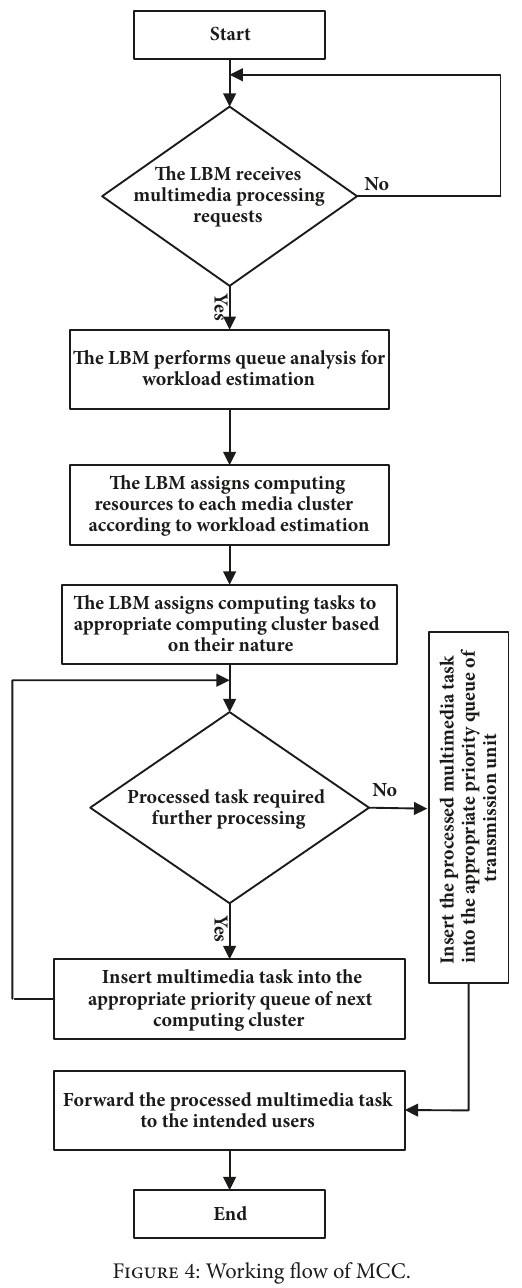
Figure 4: Working flow of MCC.